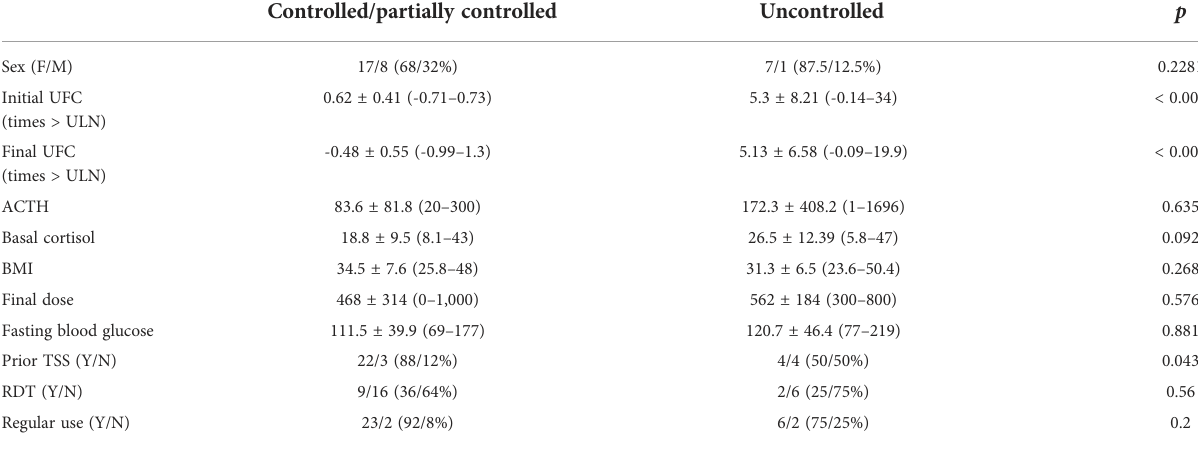
TABLE 3 Baseline characteristics of Cushing ’ s disease patients according to therapeutic response to ketoconazole.